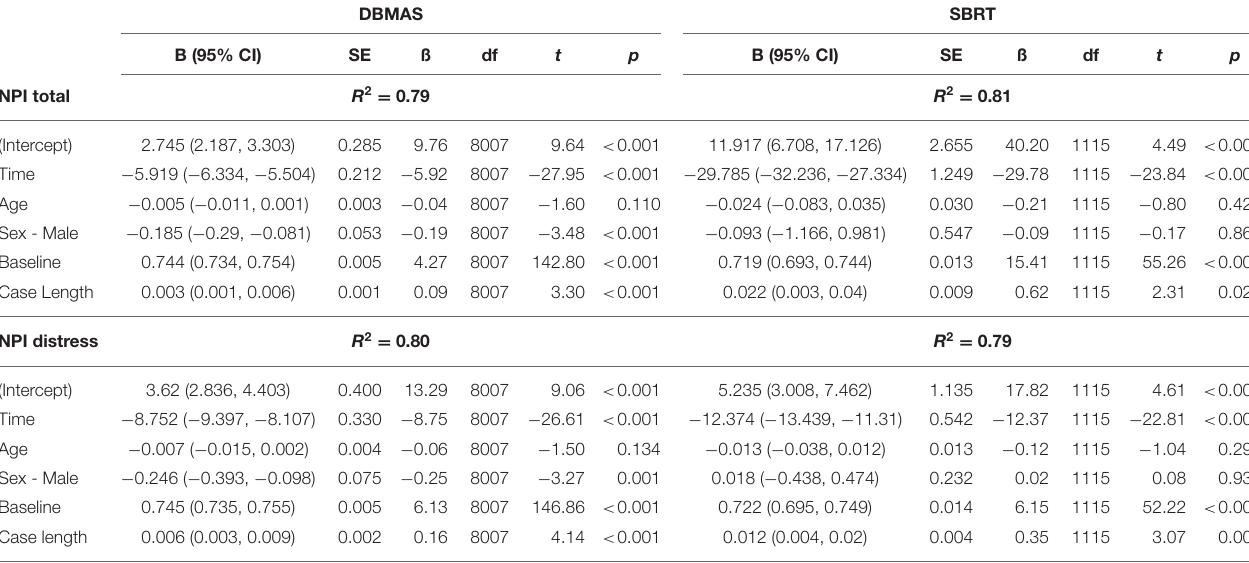
TABLE 3 | Association between total NPI and total distress scores and other covariates for each DSA program. DBMAS SBRT